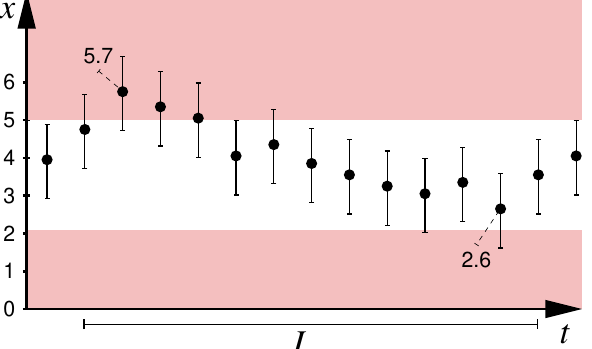
Figure 1. Model-free monitoring of temporal conditions under metric interval-type uncertainty. The uncertainty intervals depicted are tight insofar that, first, their width is ± 1 and thus coincides with the sum of the two errors sensor offset and random noise and, second, that in the absence of any known model of the system dynamics, no reach-set propagation across time instances is possible. Evaluation of φ based on interval arithmetic [12] therefore remains inconclusive, given that some uncertainty intervals (namely the ones at times t = 3 and t = 12) overlap with the red areas, yet none falls completely into this forbidden range. As the intervals depicted represent the sharpest possible state estimates w.r.t. the metric error model discussed here, monitoring approaches based on first applying best-possible state estimation and subsequently evaluation of the monitoring condition are equally prone to remaining